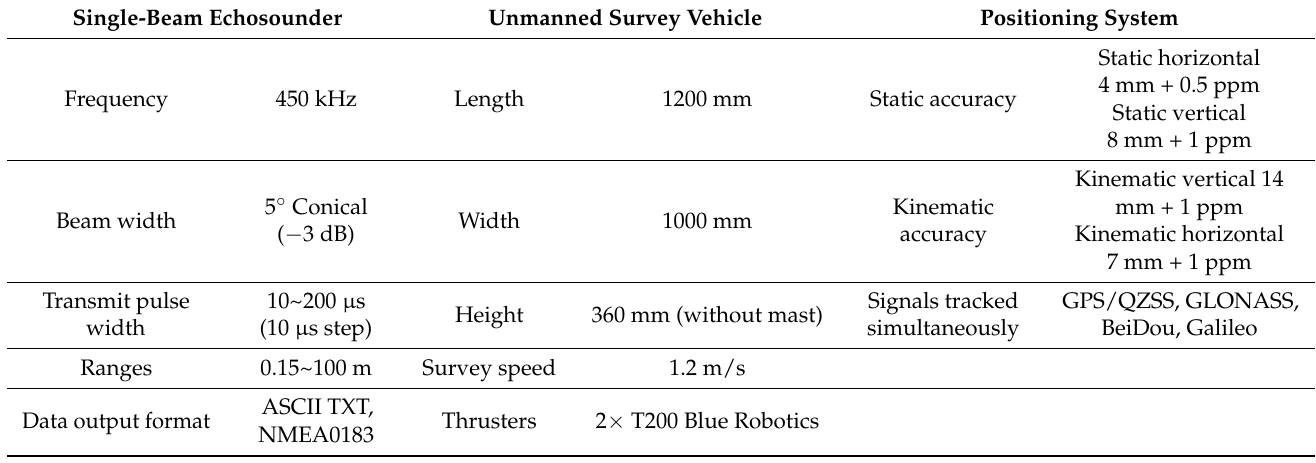
Table 1. USV survey system parameters.